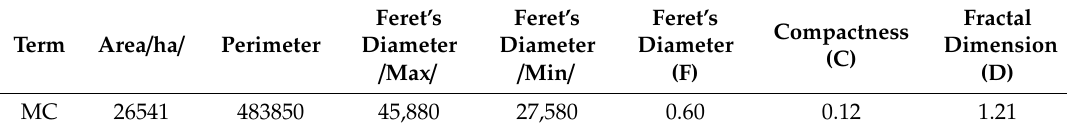
Table 4. Fractal dimension under the monocentric concept